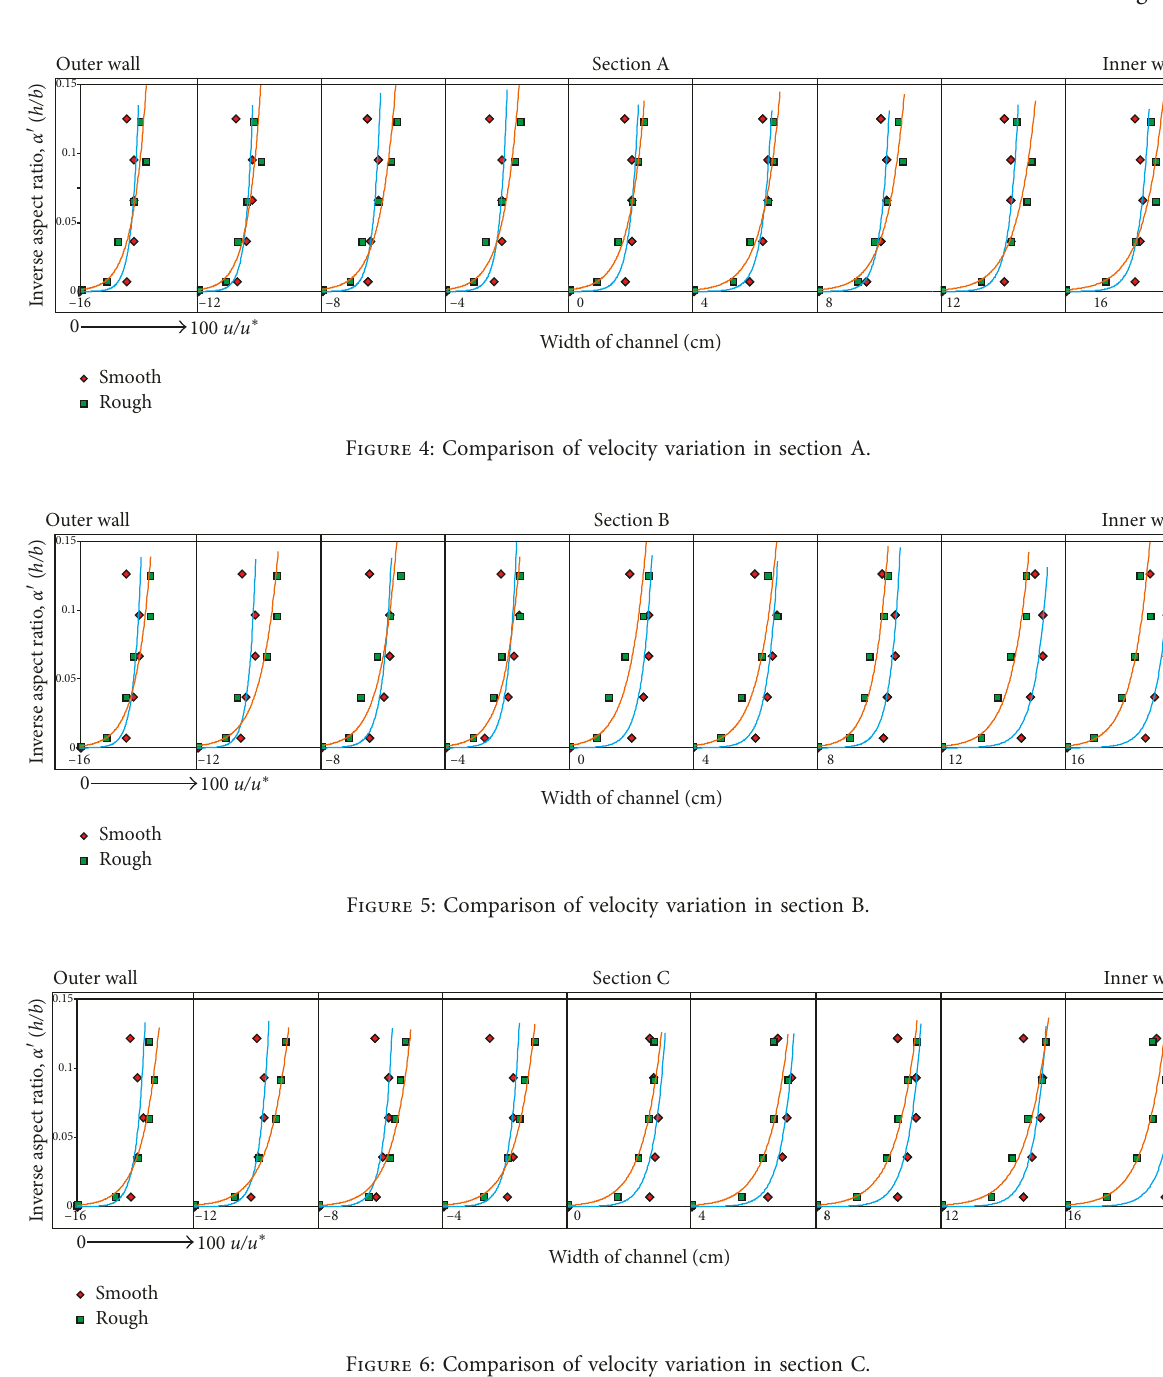
Figure 6: Comparison of velocity variation in section